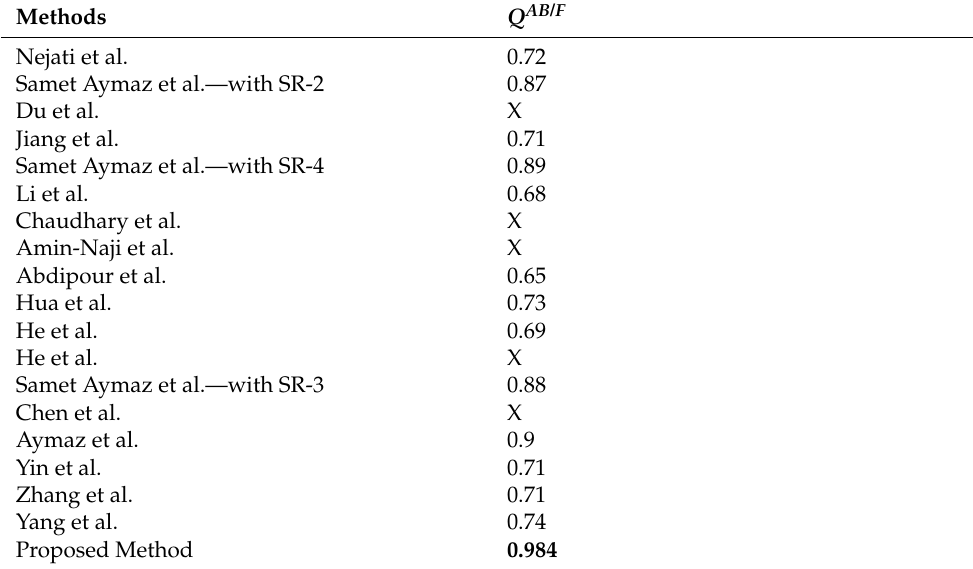
Table 6. The outcomes for the clock image and comparisons with existing techniques in the literature ([27]).